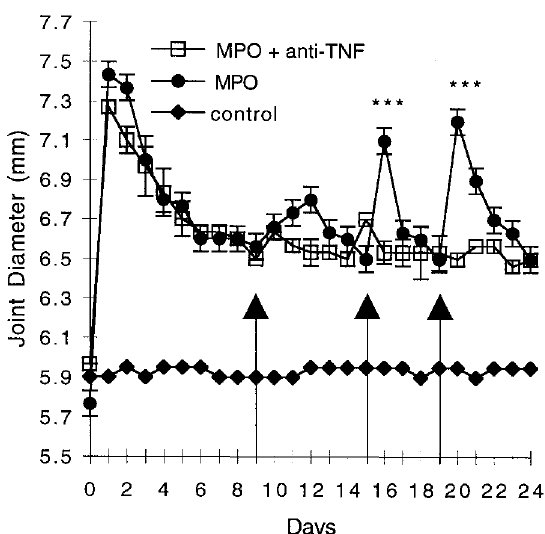
FIG. 4. The inhibition of peri-articular swelling after injecting simultaneously enzymatically active myeloperoxidase (MPO) and mannans. On day 0, animals were injected with 10 m l of PG-APS (2 m g rhamnose/joint) into the left ankle joint and 10 m l normal saline into the right ankle joint. After the treated ankle joint returned to ‘baseline’, the re-injecting regimen was started. On days 9, 15, and 19 (as depicted by the arrows), animals were re-injected simultaneously in the left ankle joint with one of the following: 10 m l MPO alone (2 m g/joint), or a combination of 5 m l MPO (2 m g/joint) and 5 m l mannans. The right ankle joint was re-injected with 10 m l of normal saline. Graphed values represent the results of 3–5 animals. The experiment was repeated at least once. The concentrations reflected in the graph are those injected into the joint. *** P £ 0.001.